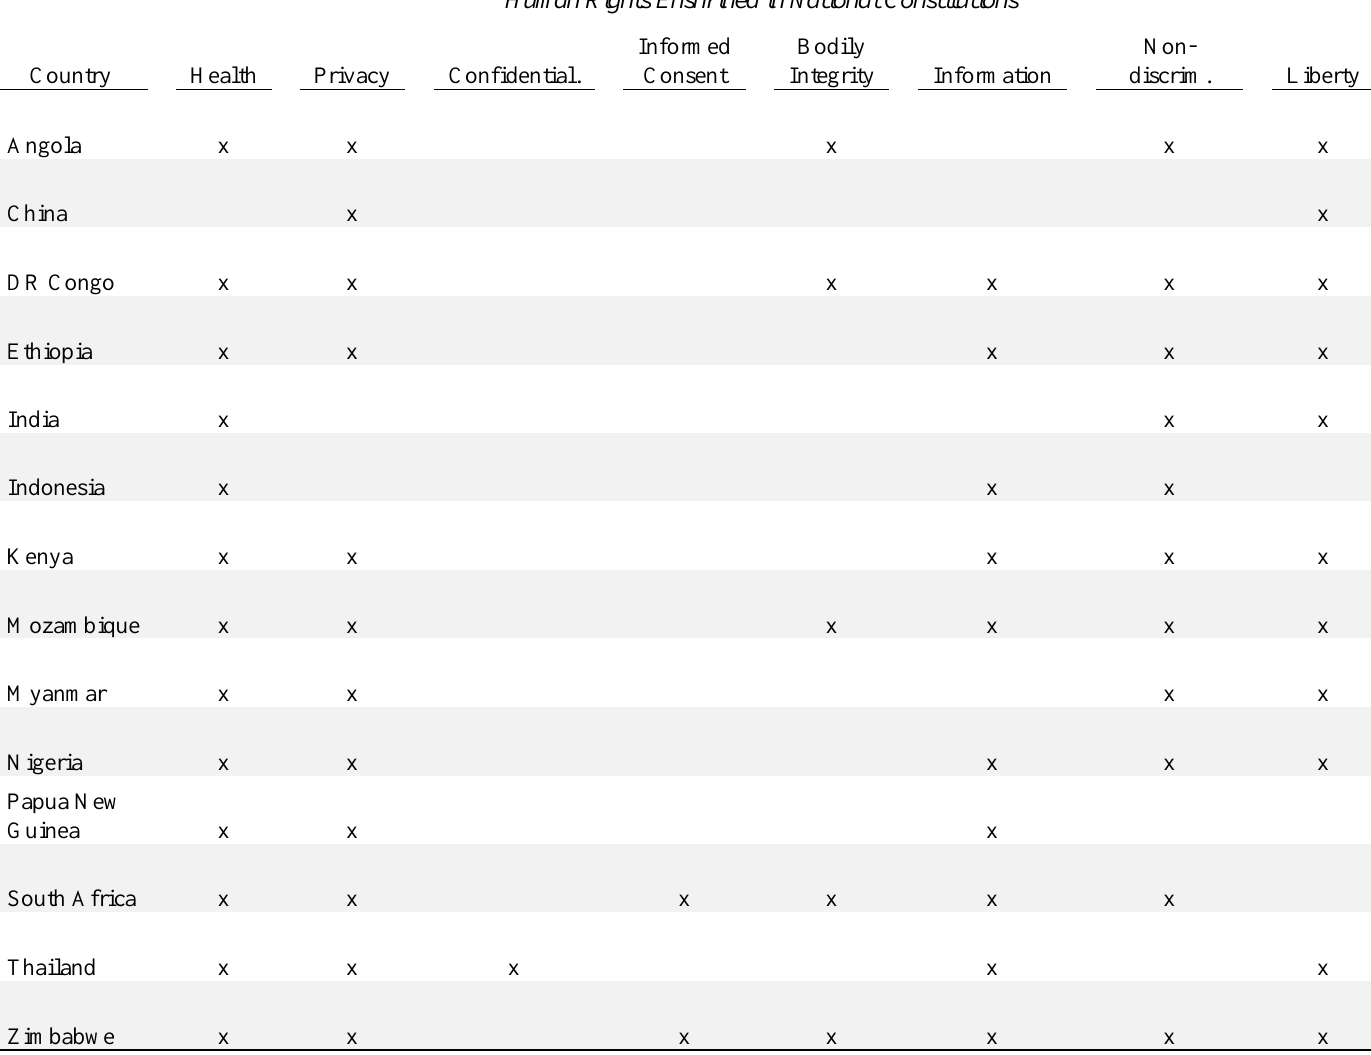
Table 4: Matrix of Human Rights in Constitutions in High TB Burden